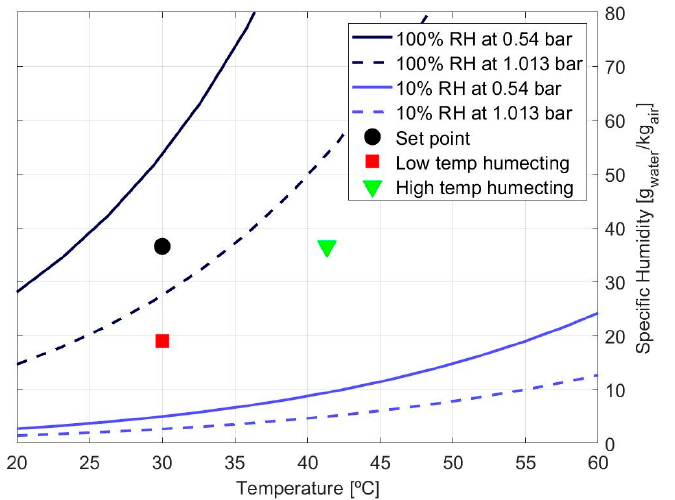
Figure 3. Example on the effect of the pressure and temperature on the water content in an air